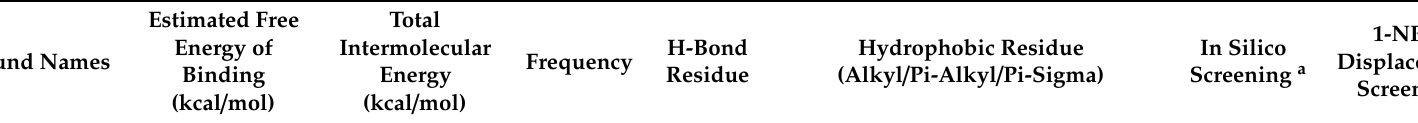
Table 1. In silico study of putative molecular residual interactions between recombinant Fel d 1 (rFel d 1) and the compounds and assessment of their capabilities to displace N-phenyl-1-naphthylamine